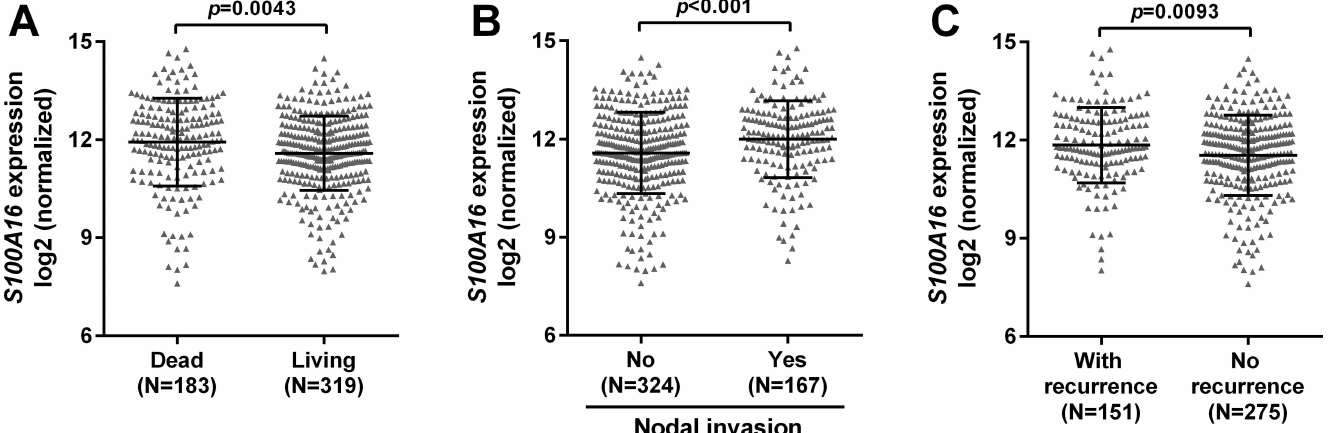
Fig 2. Comparison of S100A16 expression between the groups with different clinicopathological parameters. A-C. Plots chart of S100A16 expression between the living and dead cases (A), between the cases with or without nodal invasion (B) and between the patients with or without recurrence (C).